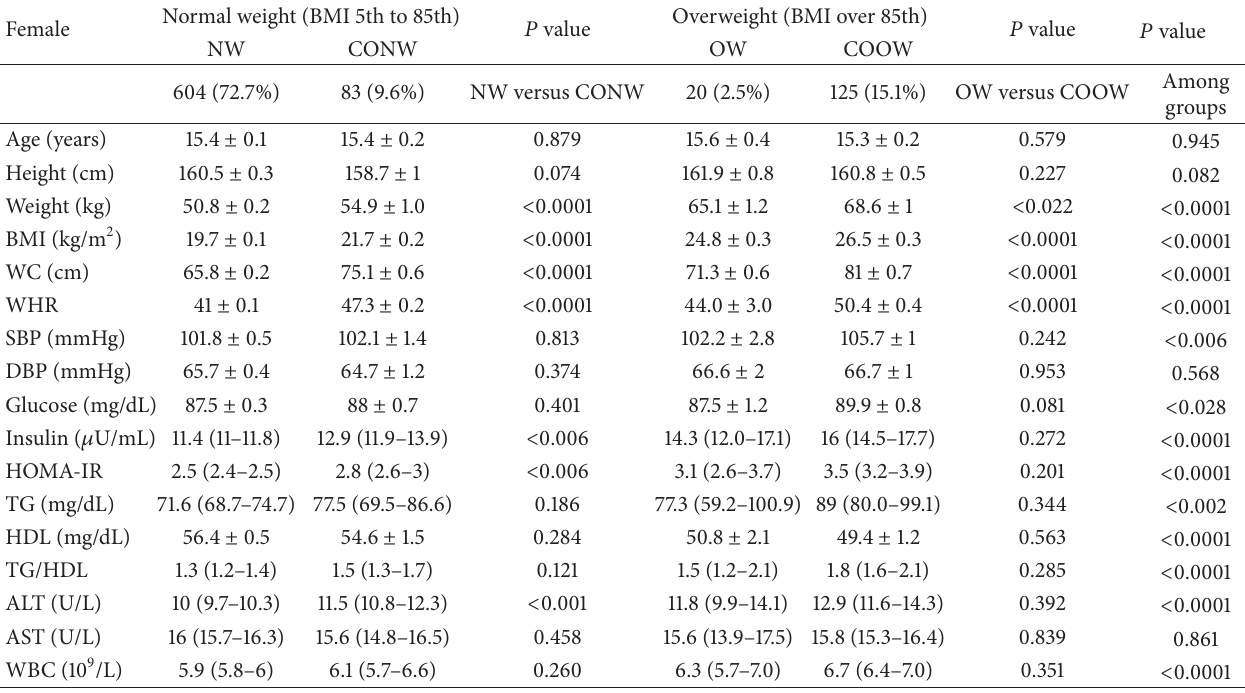
Table 1: Subject characteristics and laboratory data according to four body composition groups in 13–18-year-old female adolescents. Normal weight (BMI 5th to 85th) 𝑃 Female